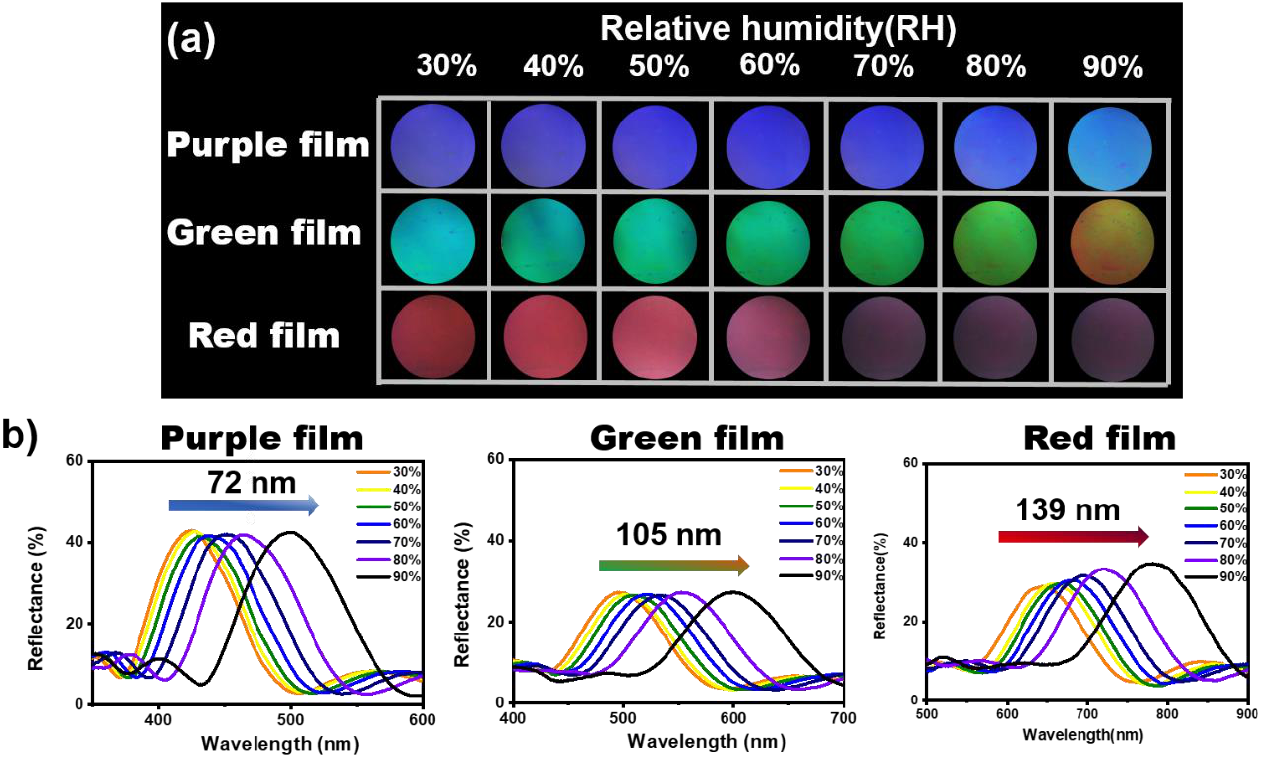
Figure 3. ( a ) Images of three films with black background after showing color changes when exposed to 30 to 98% RH level. ( b ) Reflectance spectra of three films as RH increased from 10 to 98%.